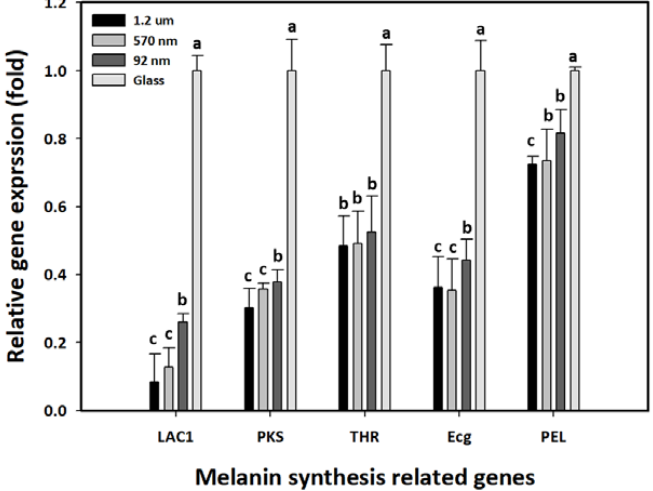
Figure 8. Relative expression of LAC1, PKS, THR, SCD, Ecg and PEL genes following treatment with different Ag samples. SR: internal reference 18 s rRNA; LAC1: laccase gene; PKS: polyketide synthase gene; THR: tetra-HN reductase scytalone gene; SCD: scytalone dehydratase gene; Ecg: exo-glucocanase gene; and PEL: pectate lyase gene.